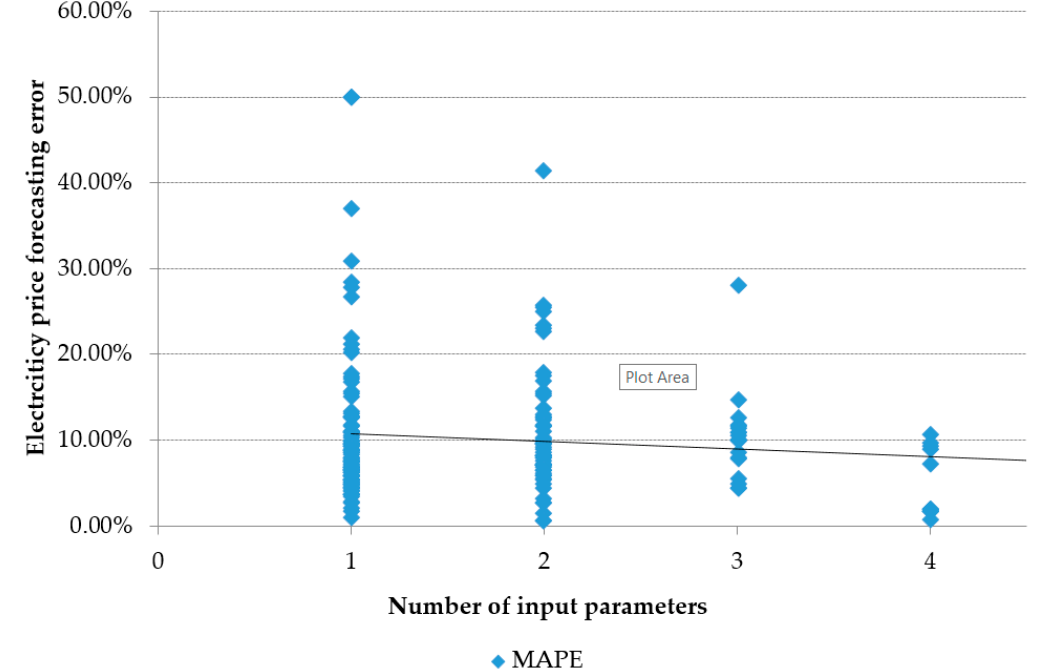
Figure 7 . Correlation between forecasting error (MAPE) and number of input parameters used for electricity price forecasting.